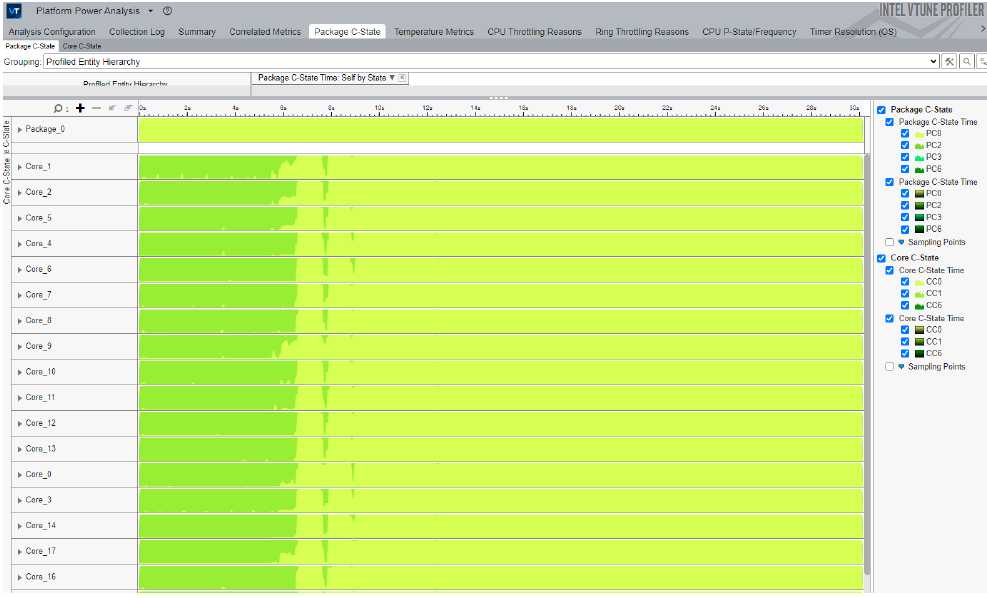
Figure 3. Intel Vtune Profiler C-state data for our PIC